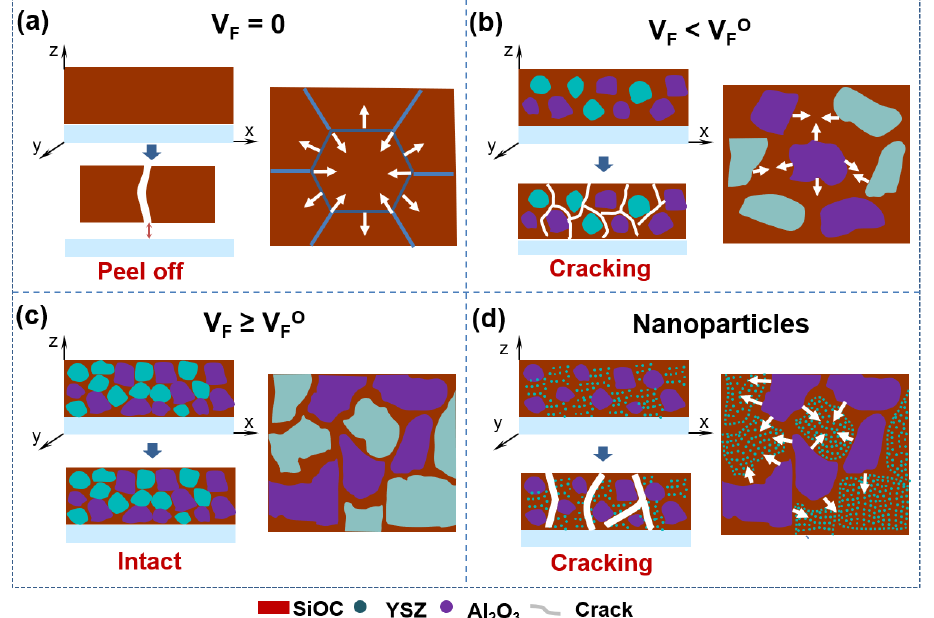
Figure 5. Schematic model of cracking mechanism in the SiOC/Al 2 O 3 /YSZ coating system: ( a ) cracking mechanism of PSO-free coatings, ( b ) cracking mechanism of coatings with PSO less than critical value, ( c ) cracking mechanism of coatings with PSO greater than or equal to critical value, ( d ) cracking mechanism of coatings with nanoscale filler particles. Blue arrowhead: transformation of coatings before and after heat treatment, white arrowhead: shrinkage trend of coatings.